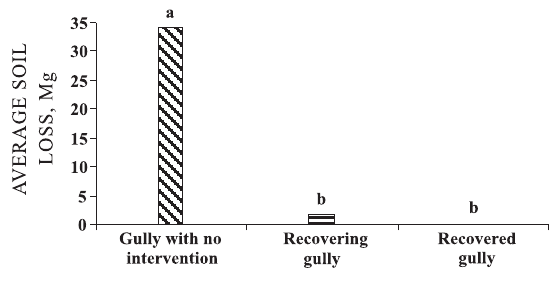
Figure 2. Average soil loss from gullies in different recovery stages. Averages of three replications (evaluations). Averages followed by the same letter did not differ from each other by Bonferroni’s t-test (5 %)